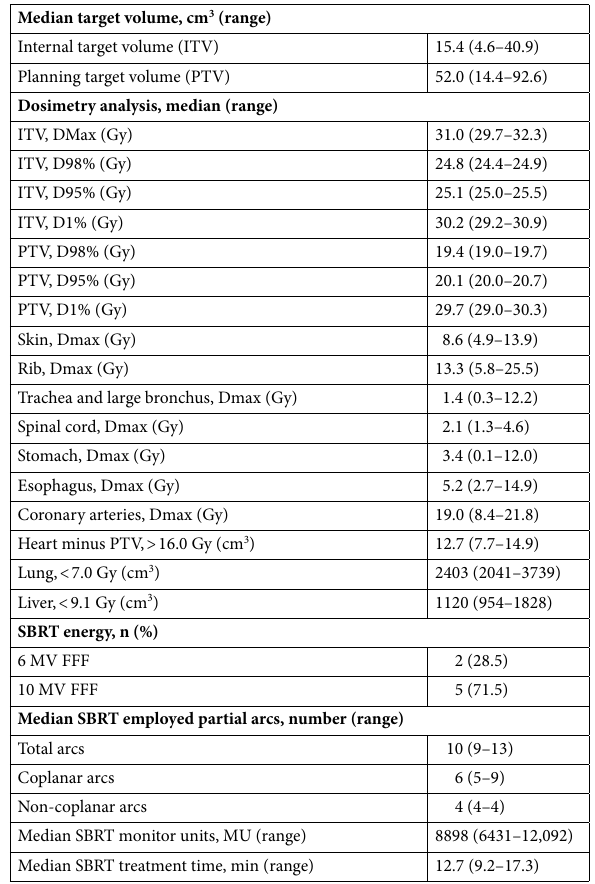
Table 2. Stereotactic body radiotherapy dosimetry and treatment details. SBRT stereotactic body radiotherapy, FFF flattening filter-free photon beam, Dmax maximal dose within the volume, D98%, D95%, and D1% minimum coverage dose of 98%, 95%, and 1% of the target volumes, respectively, Heart minus PTV , heart volume excluding the PTV; > 16.0 Gy, volume receiving at least 16 Gy; < 7.0 Gy and < 9.1 Gy, volumes receiving < 7 Gy and 9.1 Gy,